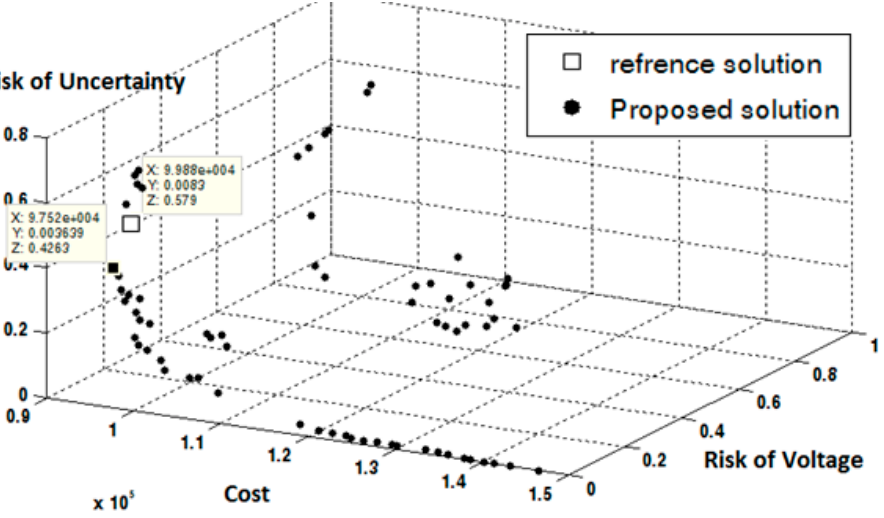
Figure 17. Comparison of reference [31] response with the Pareto Front obtained from fixed capacitor placement .